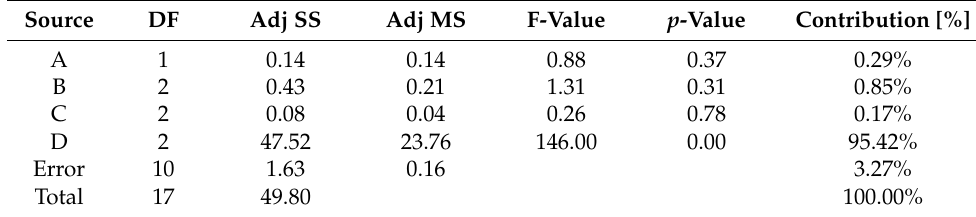
Table 9. ANOVA for flexural